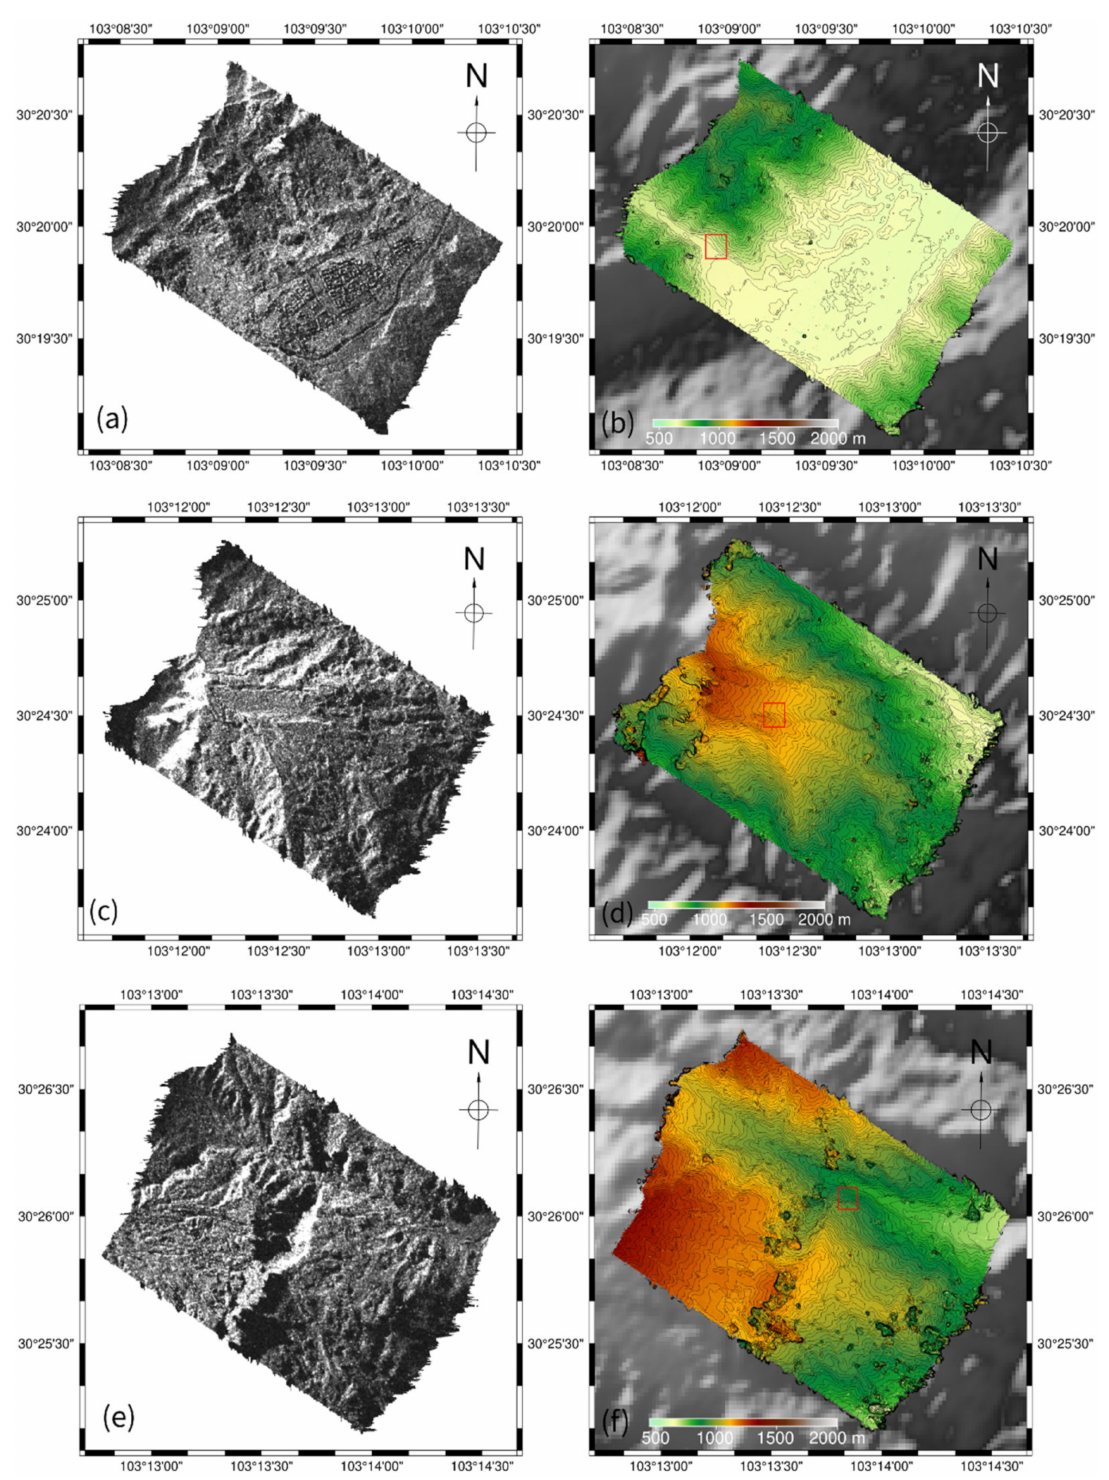
Figure 11. Geocoded scene magnitude maps and height maps of the Qionglai experiment. ( a , b ) refer to the magnitude map and height map of the first scene, ( c , d ) refer to the seventh scene, ( e , f ) refer to the ninth scene. The squares in ( b , d , f ) mark detail analysis